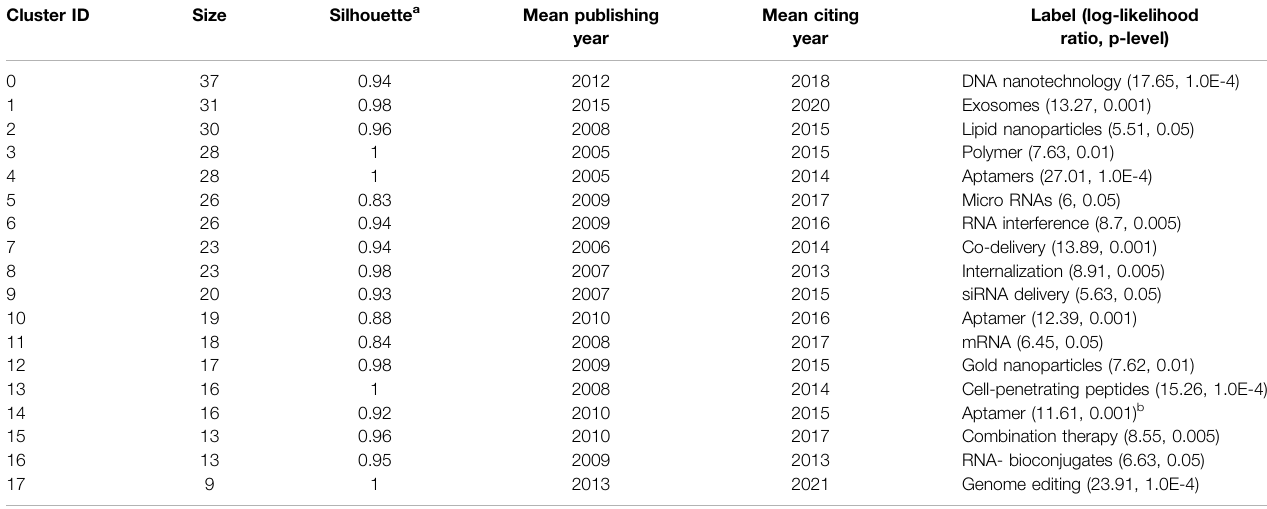
a The value of silhouette shows the homogeneity of a particular cluster; a credible silhouette score tends to be close to 1 in general. b In Figure 3 , cluster #14 was labeled poly(l-lysine) by using a mutual information algorithm, which is speculated to be a bug or special setting of CiteSpace.